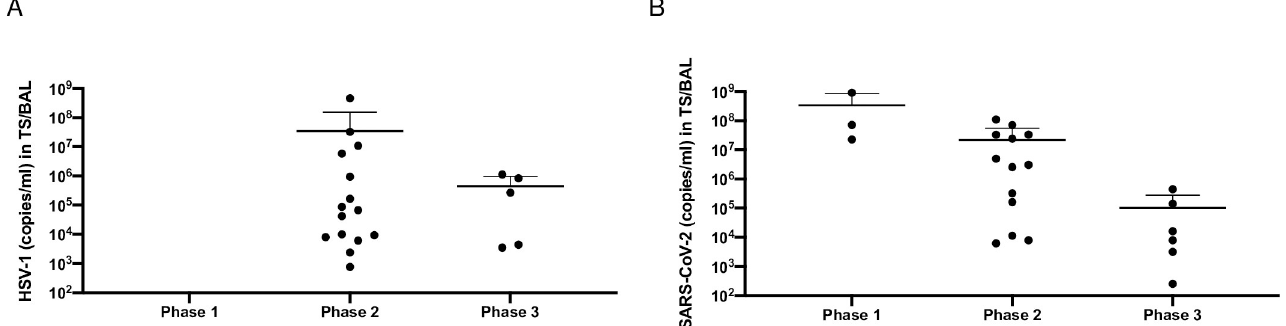
Fig 2. Time course of HSV-1 (A) and SARS-CoV-2 (B) detection in tracheal secretion (TS) or bronchial lavages (BAL) in copies/ml represented in 3 phases (phase 1: day 1–10, phase 2: day 11–30 and phase 3: day 31–40) starting at symptom onset.